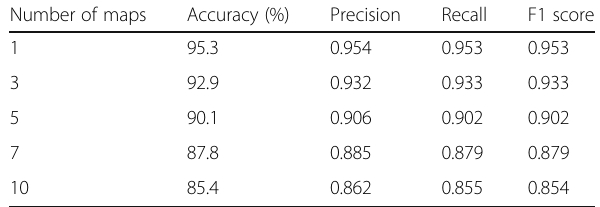
Table 7 Random Forest classification